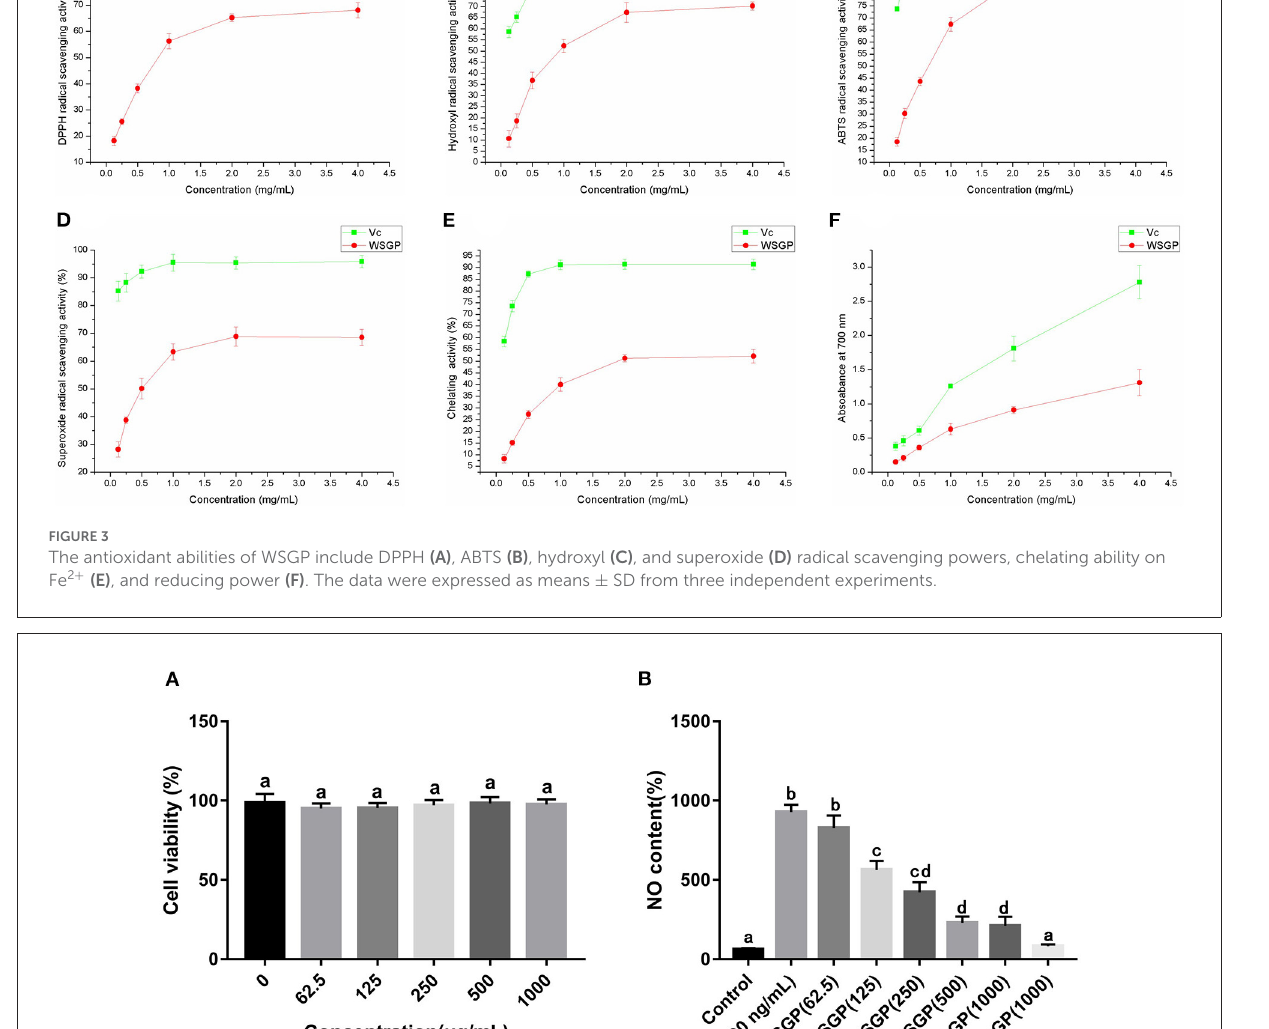
survival rate of 62.5 µ g/mL of WSGP-treated RAW264.7 was the lowest (95.18%), indicating that WSGP concentration had no toxic effect on RAW264.7 ranging between 0 and 1